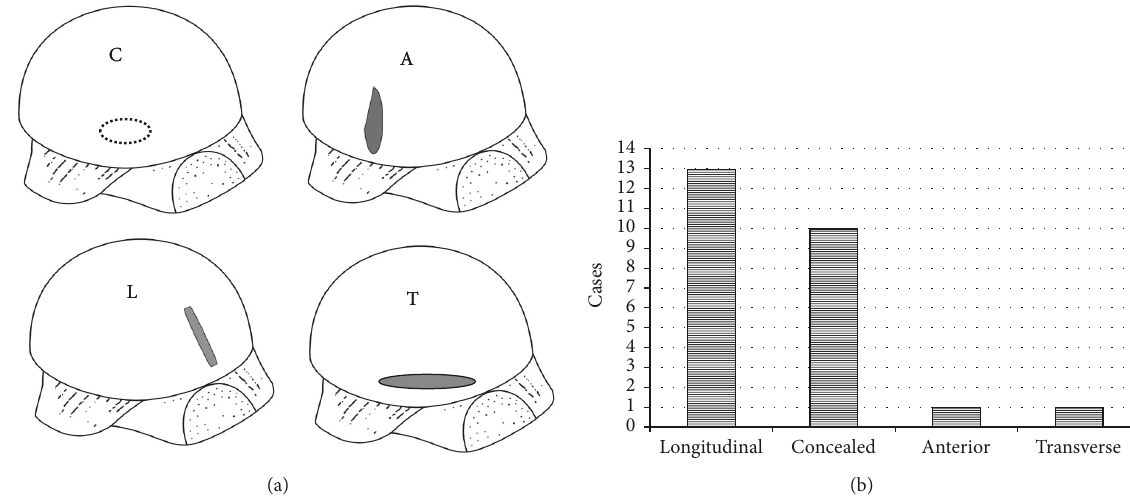
Figure 2: Tear characteristic . (a) Tear characteristic schema. C; concealed tear, A; anterior tear, L; longitudinal tear, T; transverse tear. (b) Concealed tear was found in 10 cases. Complete tear was found in 15 cases; longitudinal tear was found in 13 cases, anterior tear was found in one case, and transverse tear was found in one case.